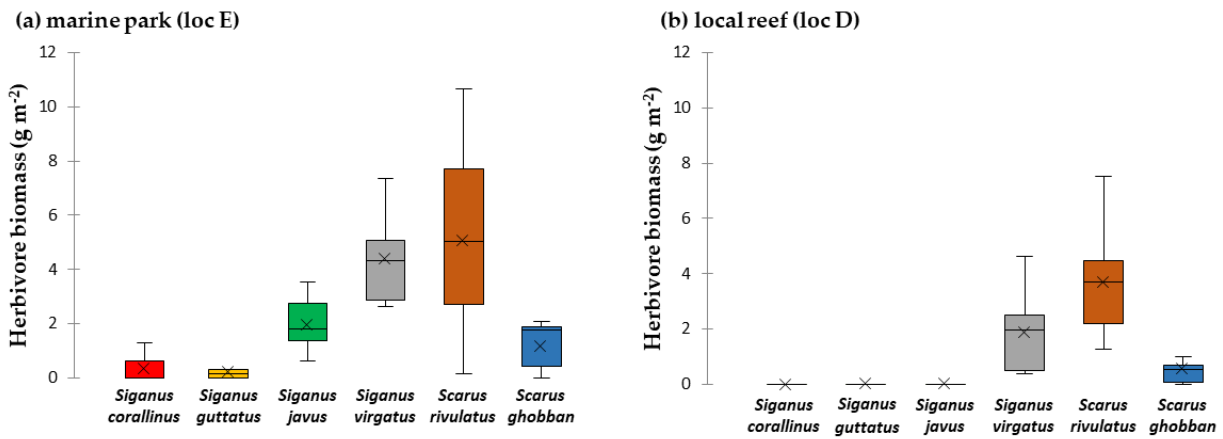
Figure 2. Herbivore biomass surveyed on the reef crest in the marine park (loc E) ( a ) and in a local reef (loc D) ( b ) in 2015. Values are given in mean g m − 2 . The boxplot shows the median and 25% quantile, the black cross indicates the mean.